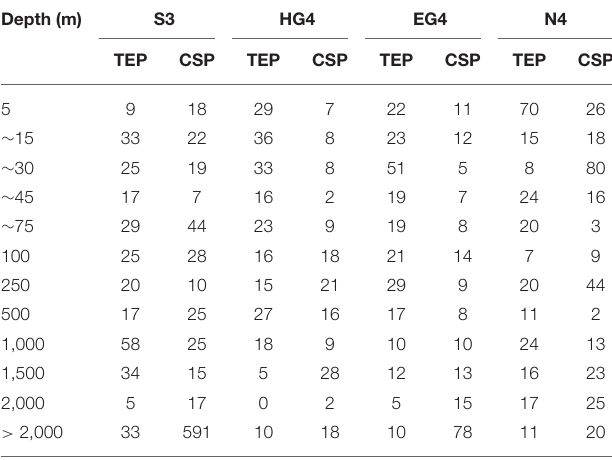
Table includes data from the entire gel particle size spectrum (1–33.5 µ m ESD). Depths indicated with “ ∼ ” represent medians of the four stations (as sampling depths in the euphotic zone were slightly adjusted at each station to sample the chlorophyll maximum and its gradient). “ > 2,000m” refers to depths below 2,000m.